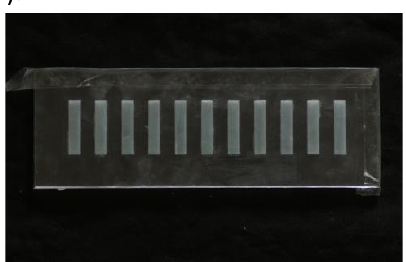
Fig 1: Preparation of samples